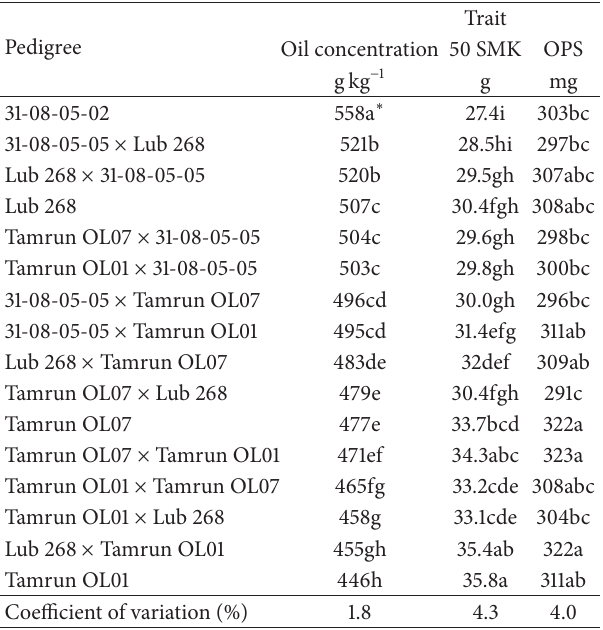
Table 1: Mean of oil concentration in gkg − 1 , weight of 50 sound mature kernels (50 SMK) in grams, and mean milligrams oil produced per SMK (OPS) of 𝐹 2 progeny and parents in a four-parent diallel of